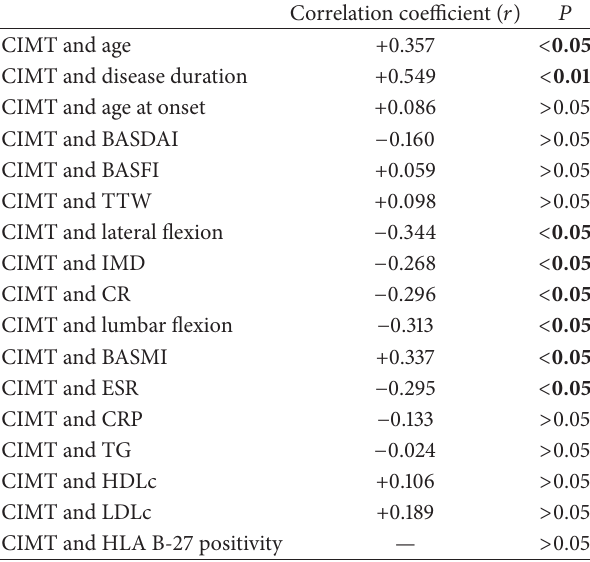
Table 2: Correlation of CIMT with markers of disease severity and